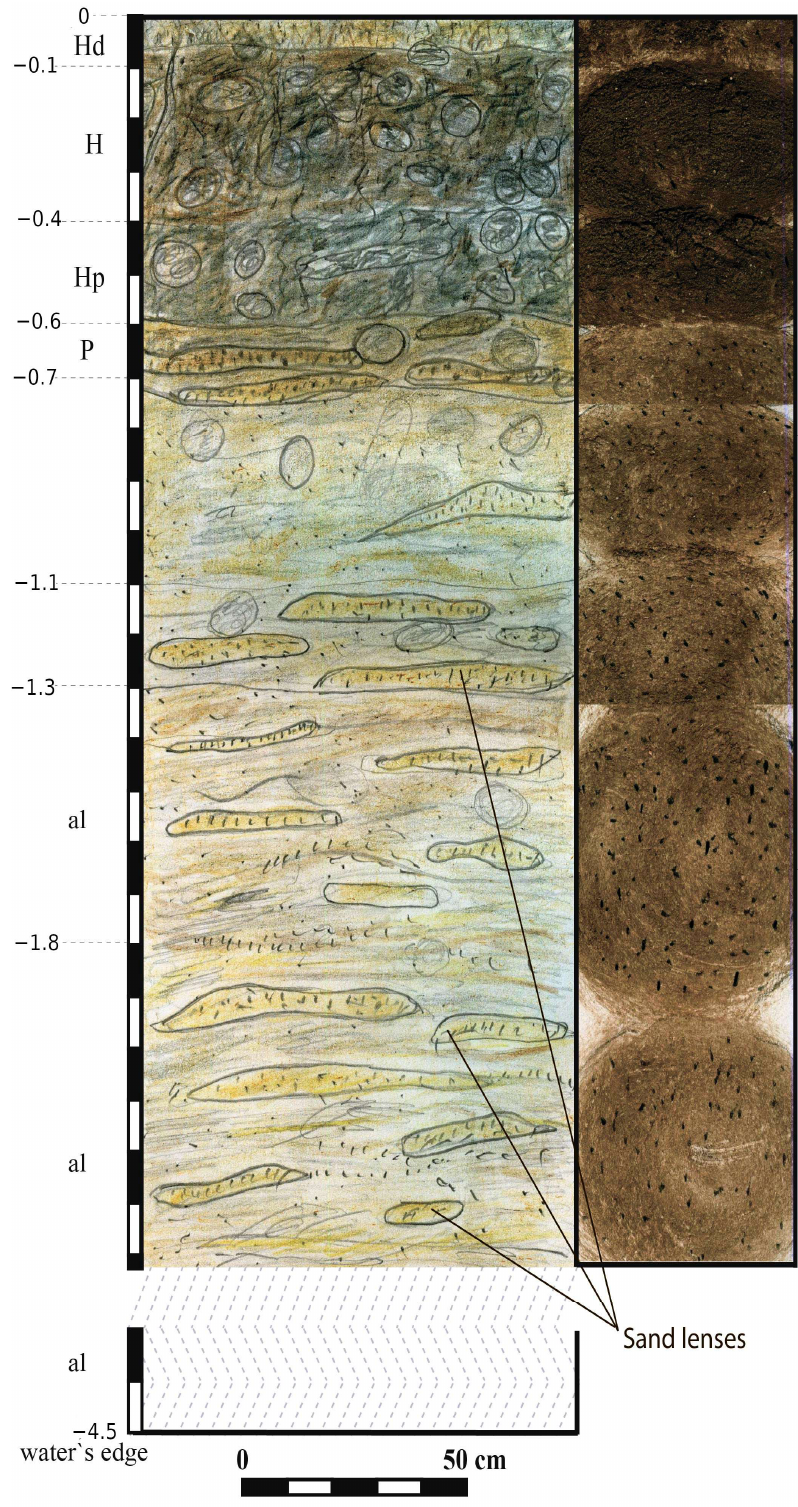
Figure 13. Melnychna Krucha. Soil-section 2. Captions: see Supplementary Table S4. Left column: soil horizons’ indices, dotted lines indicate changes of horizons; central column: schematic drawing; right column: photos of actual soil textures from respective horizons of the section, taken afield by gluing a respective sample to a sheet of paper. Elaboration—ZM.